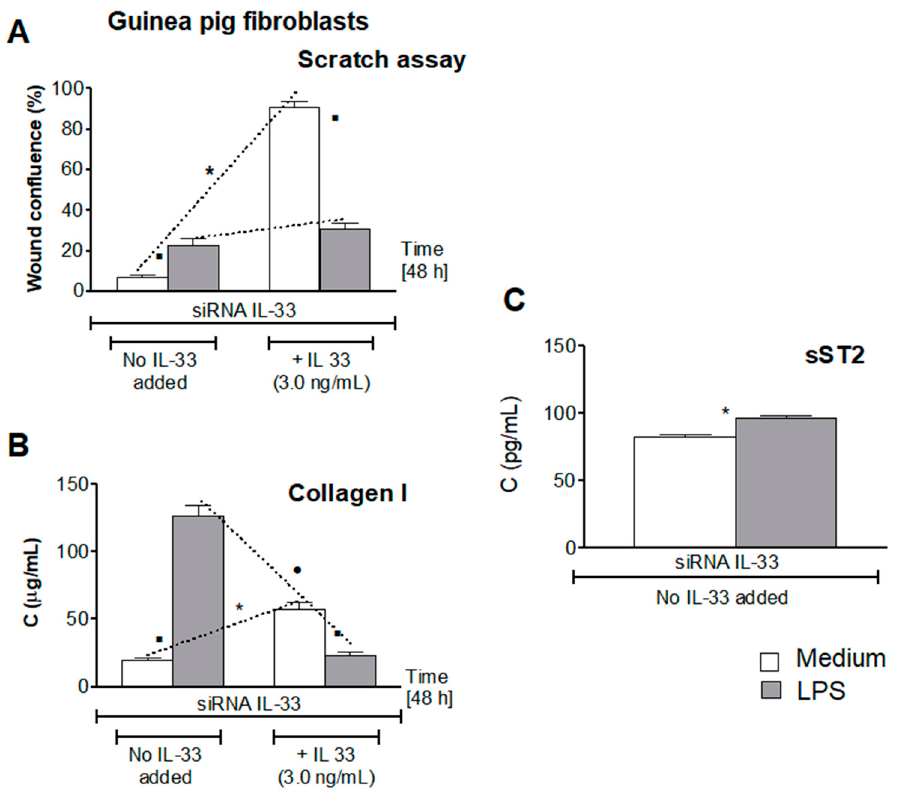
Figure 6. Pro-regenerative activity of guinea pig fibroblasts. Cells transfected with siRNA IL-33, which were not exposed or exposed to lipopolysaccharide (LPS) H. pylori in medium without or with IL-33 3.0 ng/mL, were used. Cell monolayers were scratched and then the cells’ ability to migrate was assessed ( A ). Cell culture supernatants were used for assessment of collagen I concentration ( B ) by the enzyme-linked immunosorbent assay (ELISA). Furthermore, the level of soluble ST2 (sST2) was assessed by the ELISA in cell cultures of siRNA IL-33 transfected cells not exposed or exposed to LPS H. pylori ( C ). Results are shown as median with the range of five experiments performed in triplicate for each experimental variant. Statistical analysis was performed using the nonparametric Mann-Whitney U test with significance of p < 0.05. * cells in medium without IL-33 vs. cells in medium with IL-33, not treated with LPS H. pylori ; ● cells treated with LPS H. pylori, in medium without IL-33 vs. cells treated with LPS in medium with IL-33; ▪ cells not treated with LPS H. pylori vs. cells treated with LPS H. pylori, in medium without or with IL-33.